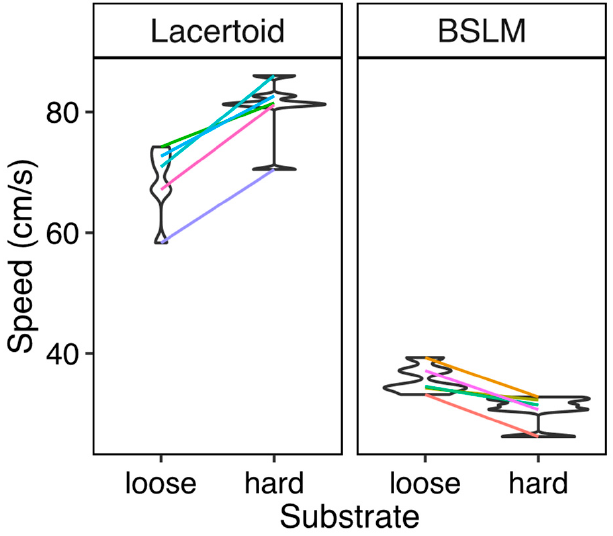
Figure 3. Sprint speed of five lacertoid and five BSLM lizard species in different substrates. Each line connects the mean of maximum speeds of species measured across each substrate, in five different temperatures. The width of violins represents the frequency of species’ values across the response variable. Colored lines connect the mean values of the same species in each treatment.